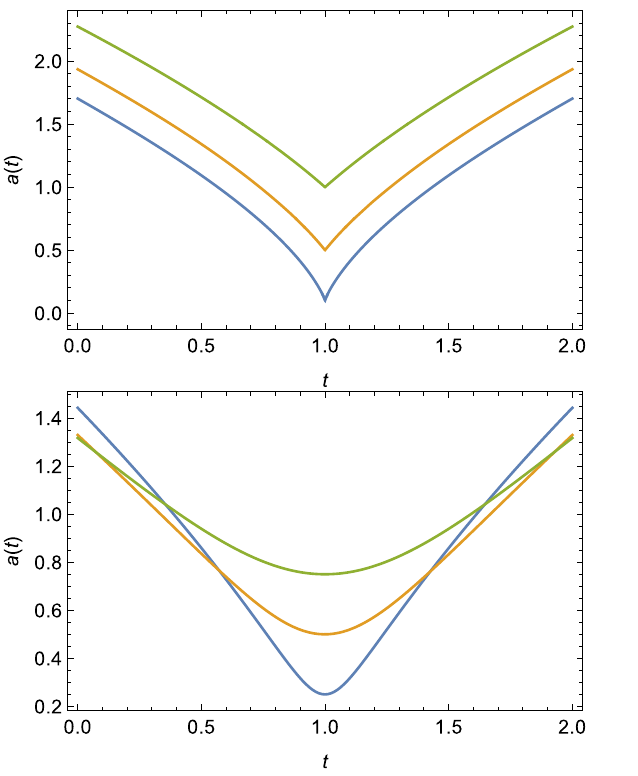
Fig. 9 Time evolution of the axion field for a 0 = − 1, ρ 0 = 10, ψ 0 = > 0. For the graph 0 . 1. For the graph on top, the initial condition da dt t = t i < on bottom, da dt t = t i